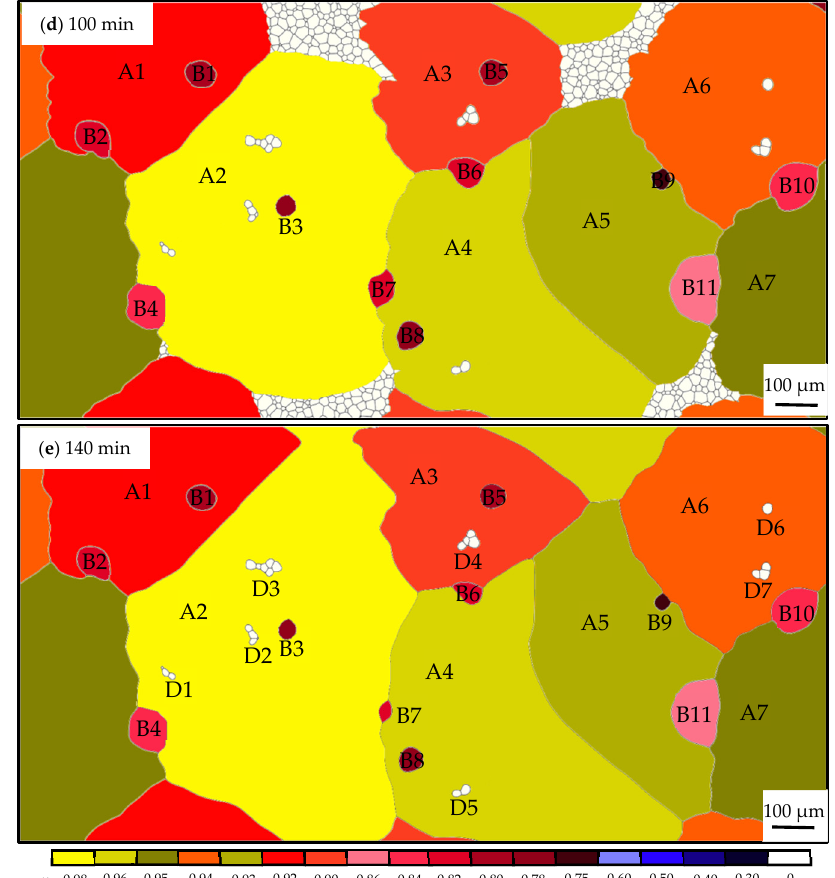
Figure 14. Simulated microstructure under various ω s and a fixed c of 0.10% at 1273 K within 140 min. ( a – e ) the microstructure evolution form 0~140 min. A1~A7: Goss grains with high ω of 0.98~0.90 ; B1~B21: other grains with medium ω of 0.86~0.30 ; C1~C21:grains with sides less than 6 and various ω s.